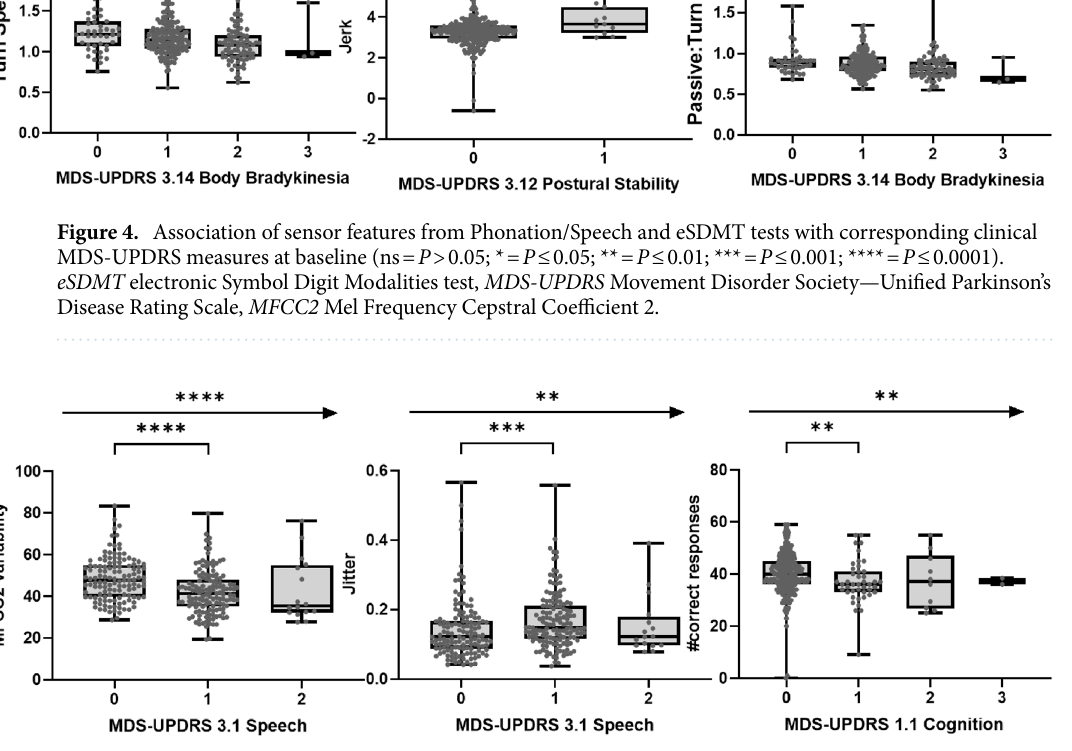
Figure 5. Association of sensor features from U-turn, Balance tests and Passive monitoring of gait with corresponding clinical MDS-UPDRS measures at baseline (ns = P > 0.05; * = P ≤ 0.05; ** = P ≤ 0.01; *** = P ≤